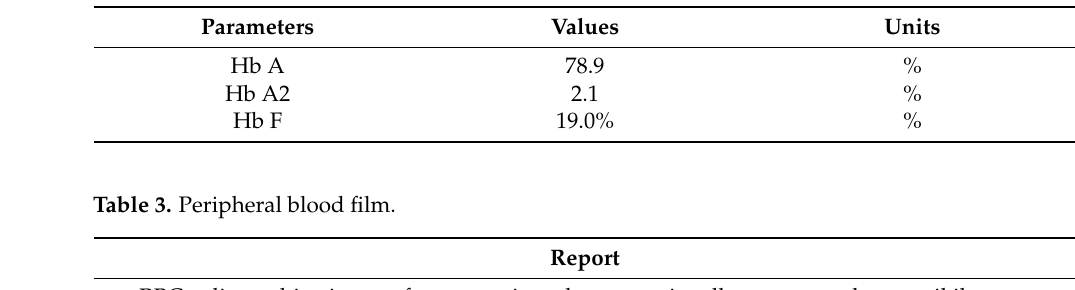
Table 2. Hb electrophoresis.